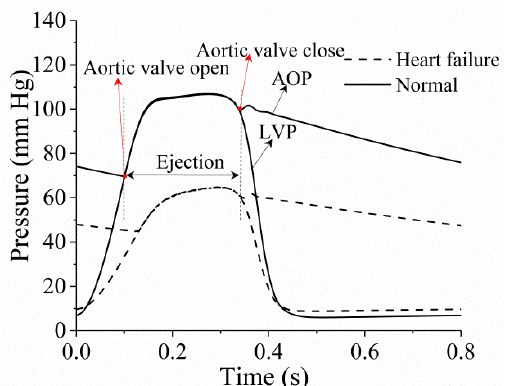
Figure 7. Characteristics of left ventricular pressure (LVP) and aortic pressure (AOP) in healthy and heart failure conditions. Solid and dotted lines represent the characteristics of the blood pressure output of normal individuals and patients with heart failure, respectively. The aortic valves had normal opening and closing function at all times.